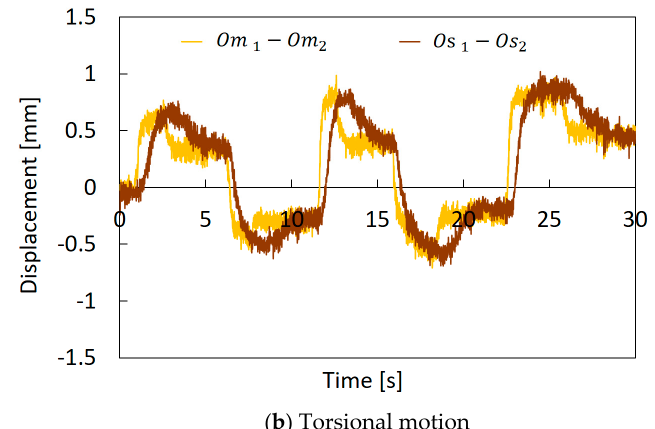
Figure 13. Comparison of encoder values between the master machine and the slave machine: ( a ) Bending motion. ( b )Torsional motion.